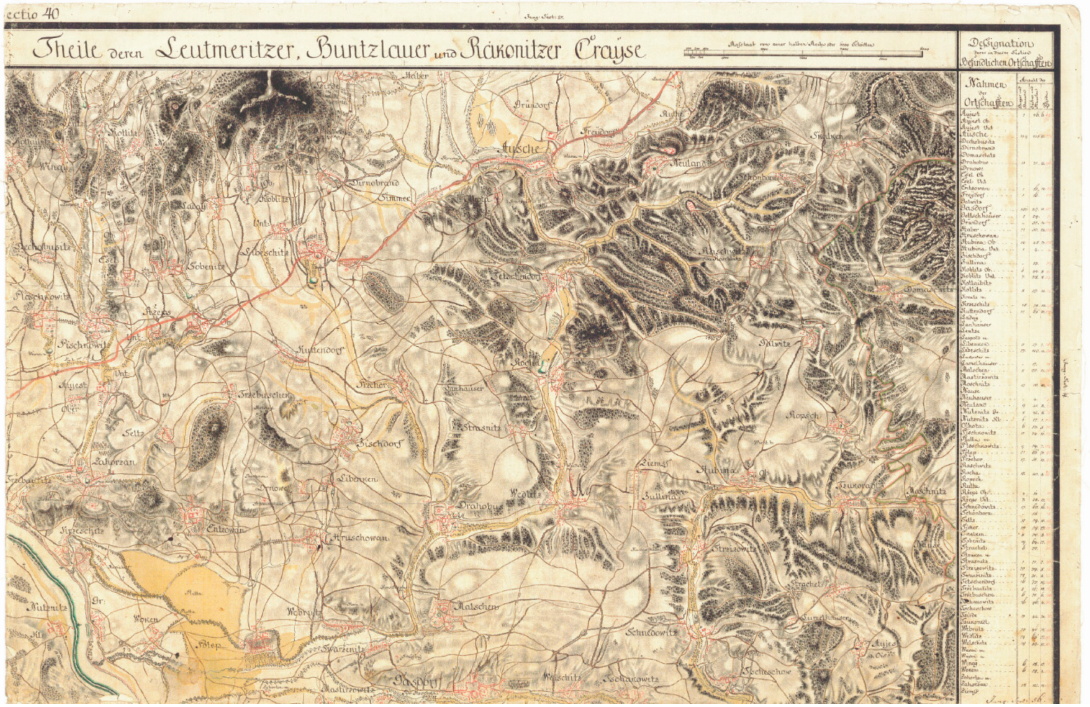
Figure 1. Example of a map sheet of the First Military